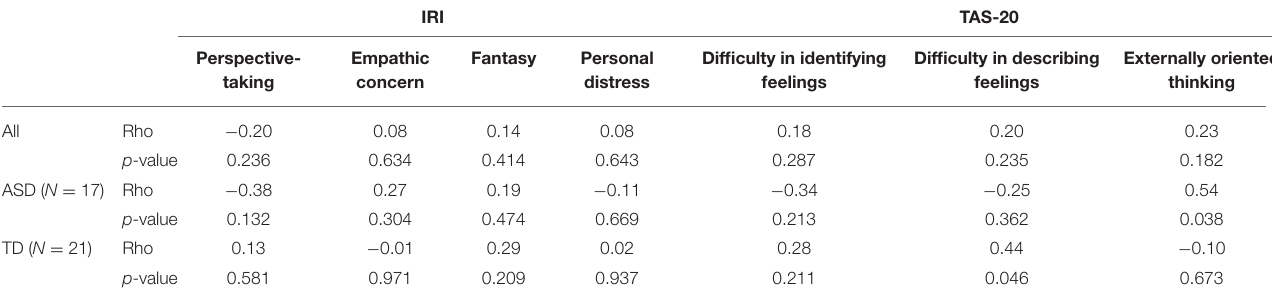
Difficulty in describing feelings feelings